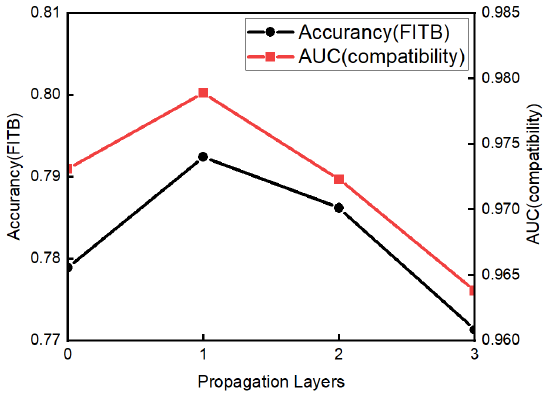
Figure 8. Test performance in different propagation layers.